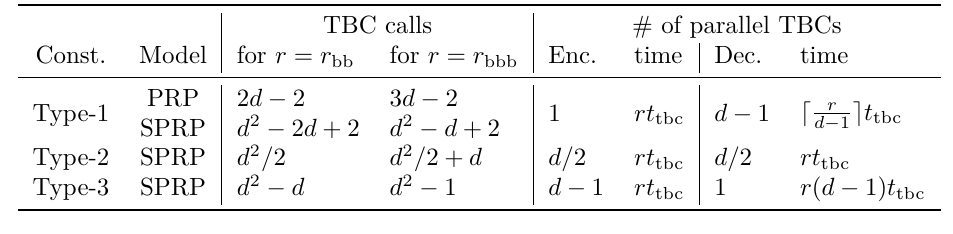
Table 3: The number of TBC calls for TBC-based GFSs. “Const.” is a dn -BC and “Model” shows the attack model. “# of parallel TBCs” shows the number of TBCs that can be processed in parallel for encryption (written as “Enc.”) and decryption (written as “Dec.”), and “time” shows the minimum processing time if the TBCs are processed in